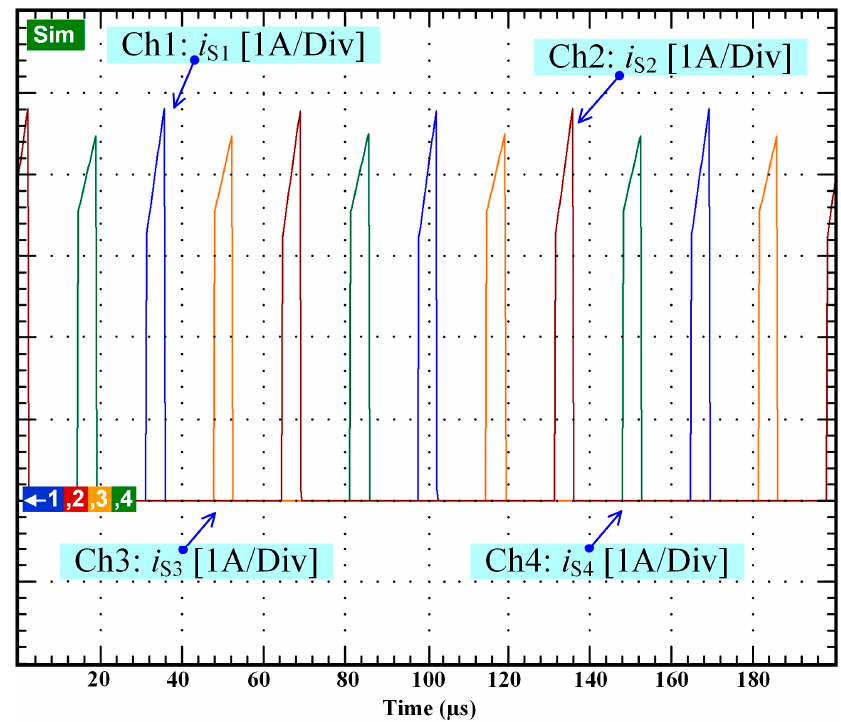
Figure 16. Simulation results: power switch currents in healthy mode.